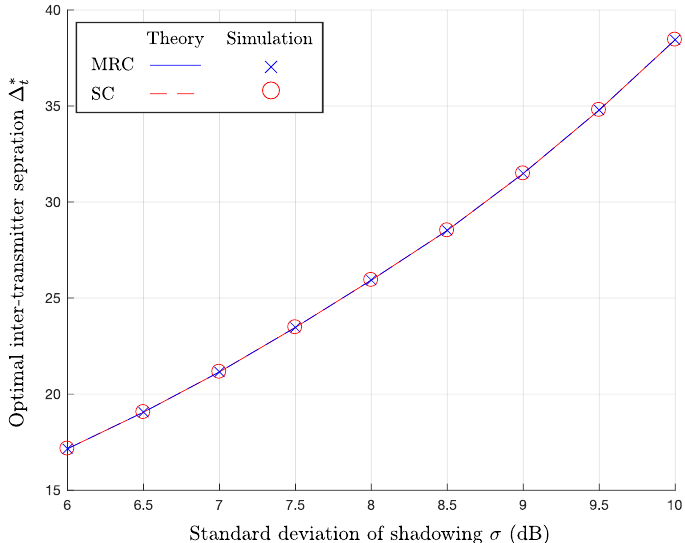
Figure 6. Optimal Inter-transmitter separation ∆ ∗ and n =